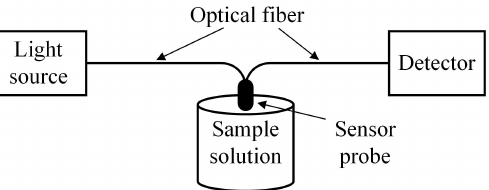
Figure 5. The schematic diagram of salinity measurement based on light intensity detection.